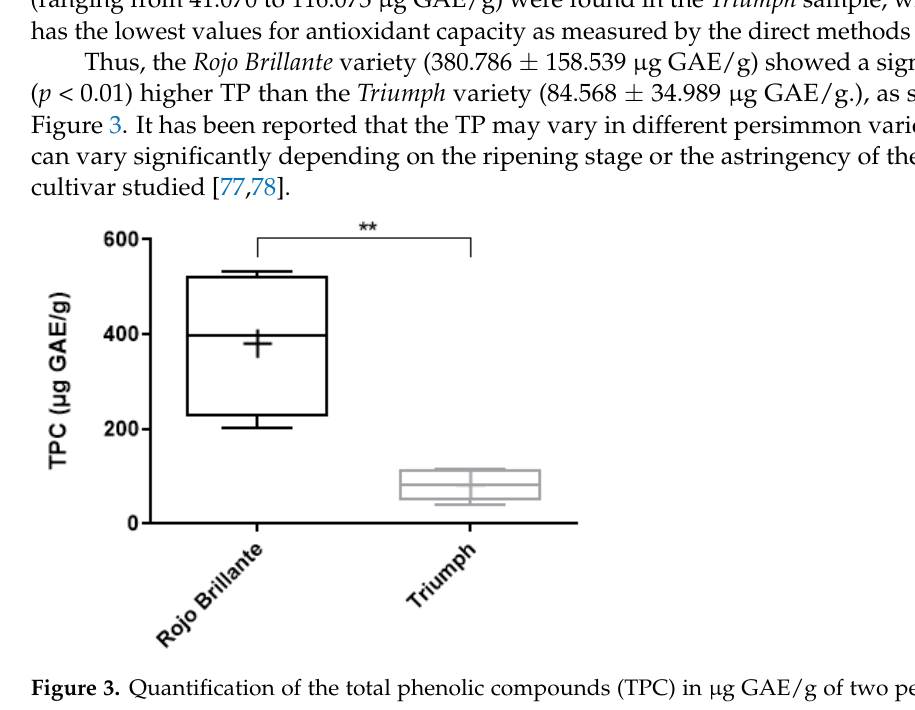
Figure 3. Quantification of the total phenolic compounds (TPC) in μ g GAE/g of two persimmon fruit varieties ( Rojo Brillante and Triumph ). ** Indicates p < 0.01 .